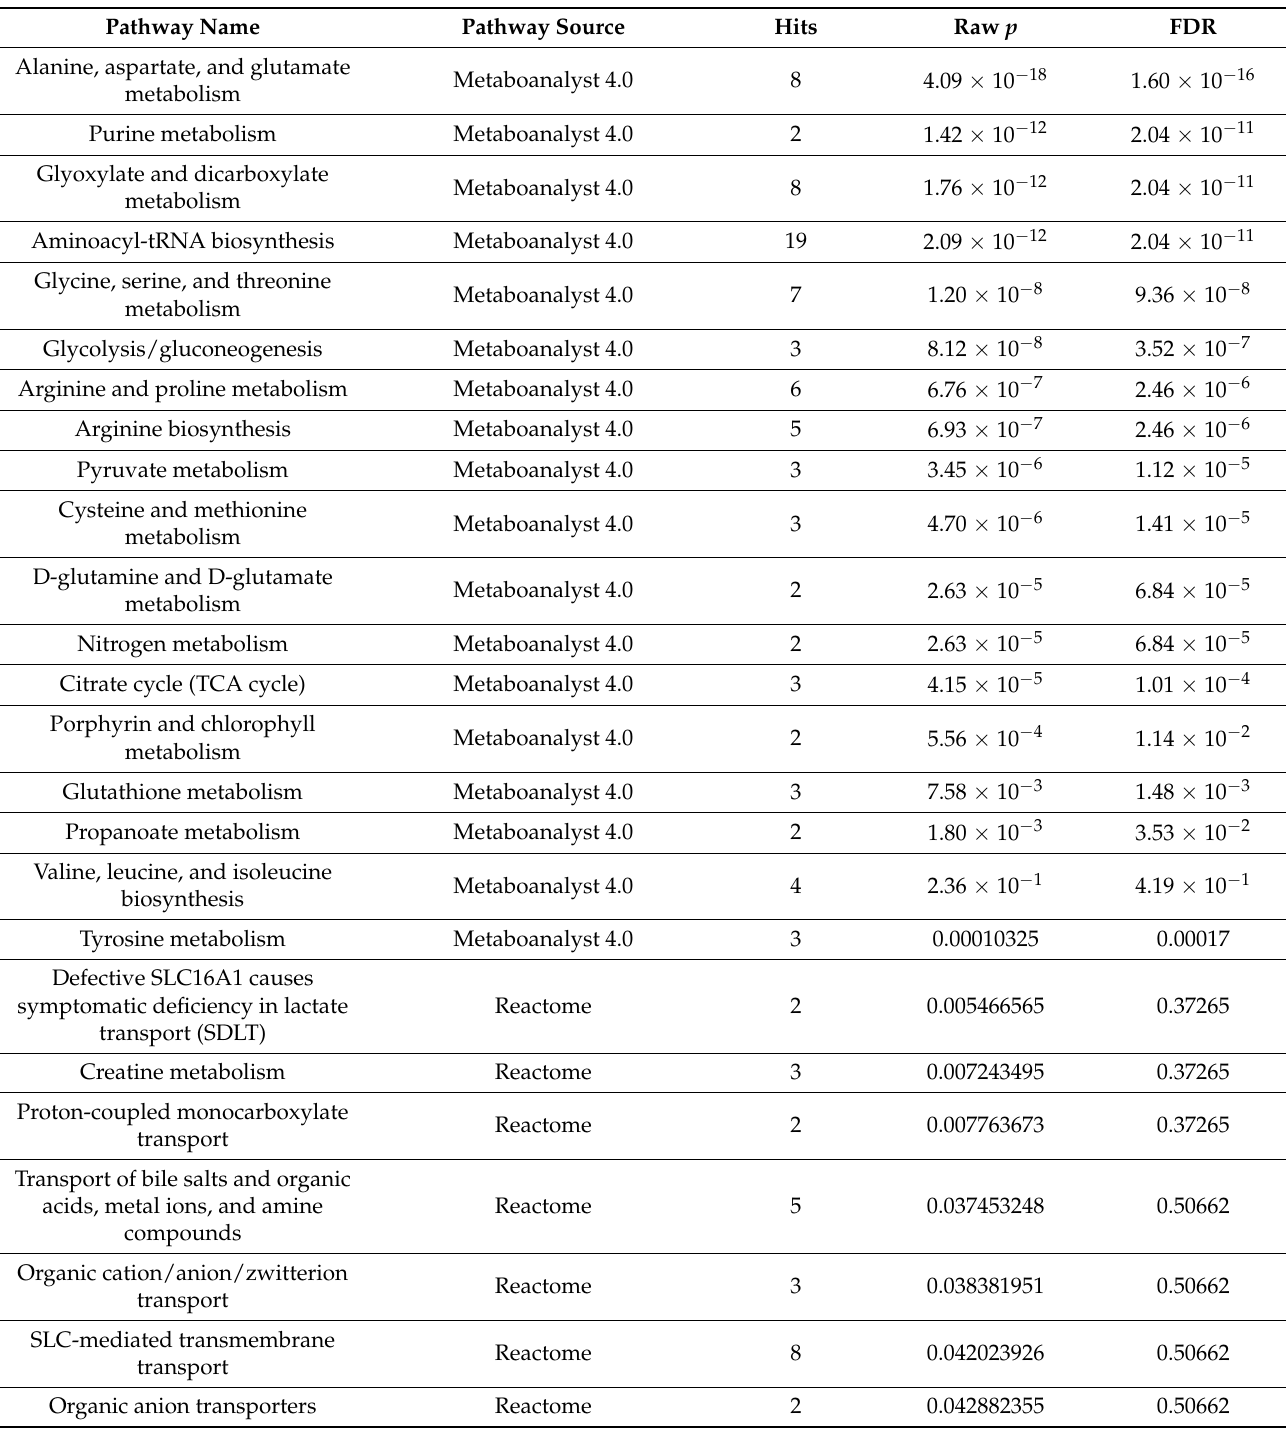
Table 2. Pathway analysis using MetaboAnalyst and